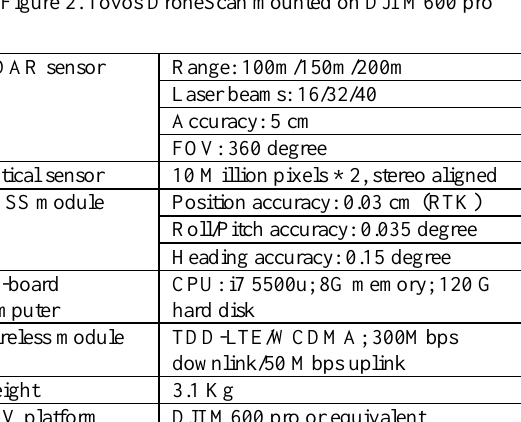
Figure 1. Data flow framework